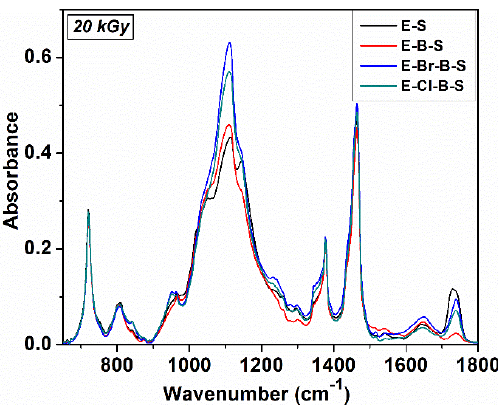
Figure 10. FTIR spectra of EPDM/butyl rubber/silica composites after irradiation at a dose of 20 kGy. The electron beam irradiation determines a significant decrease in the intensity of the absorption band at 1735 nm (Figure 10) due to the crosslinking process, in agreement with previous data [44] because the double bonds from TMPT are consumed during the irradiation process. The significant change of the IR absorption bands of the irradiated EPDM composites was observed at lower